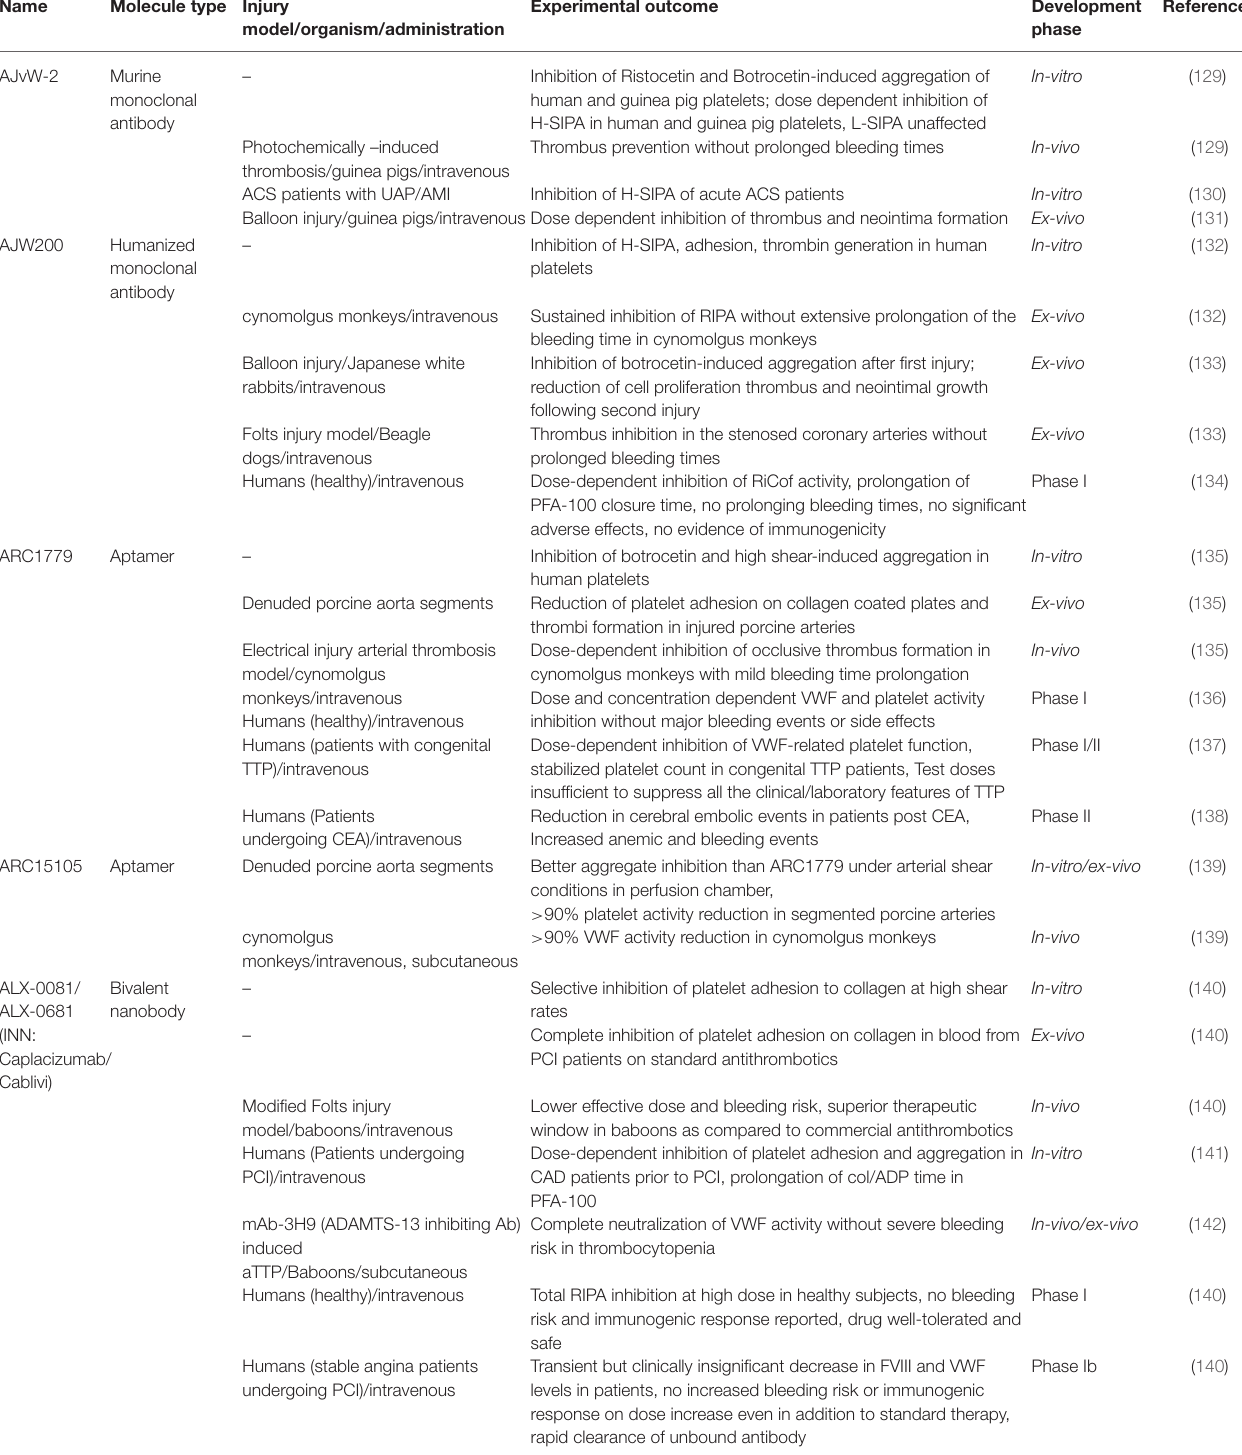
TABLE 1 | Outline of approaches that inhibit VWF-GPIb α interaction specifically under high shear